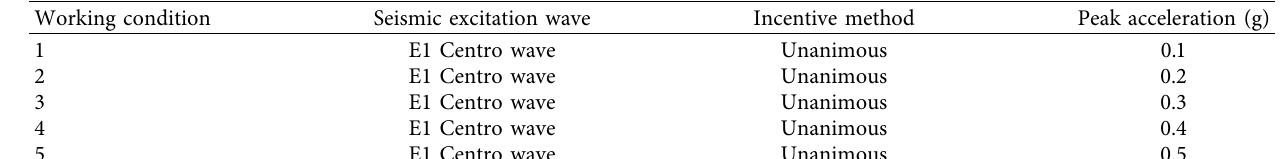
Figure 6: Acceleration time-history curve and Fourier spectrum of the representative E1 Centro wave. Table 3: Shaking table model test conditions of underground structures.